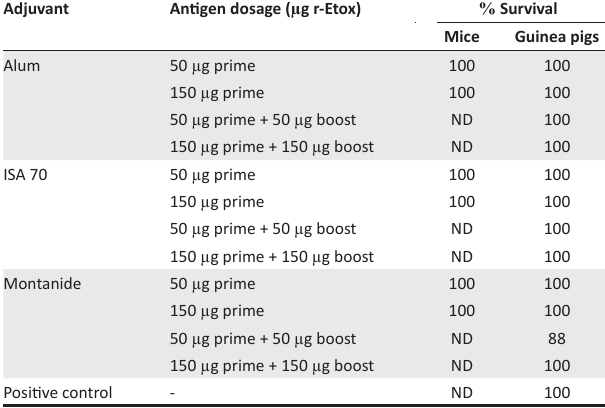
FIGURE 2: Effect of subcellular targeting of recombinant toxoid protein on accumulation. Transient expression of the recombinant toxoid protein in agroinfiltrated Nicotiana benthamiana leaves as measured by an anti- epsilon toxin enzyme-linked immunosorbent assay on crude extracts at 3, 6 and 9 days post-infiltration. TABLE 2: Safety of plant-based enterotoxaemia vaccine candidates in mice and guinea pigs. Adjuvant